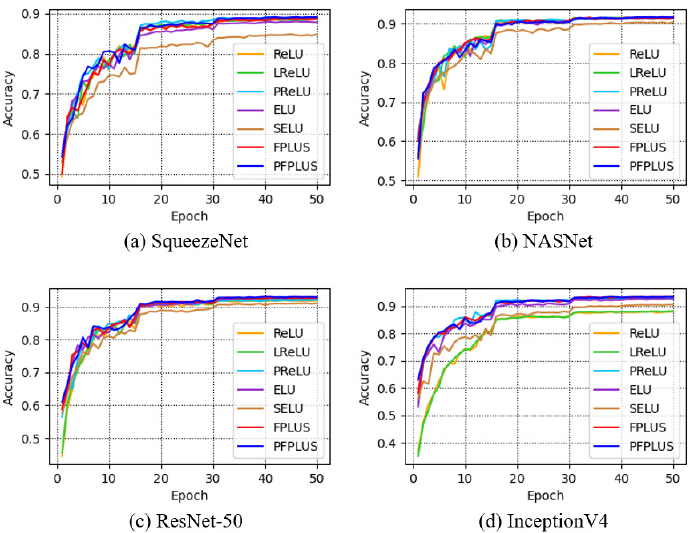
Figure 13. Curves of validating accuracy for each network applying diverse activation